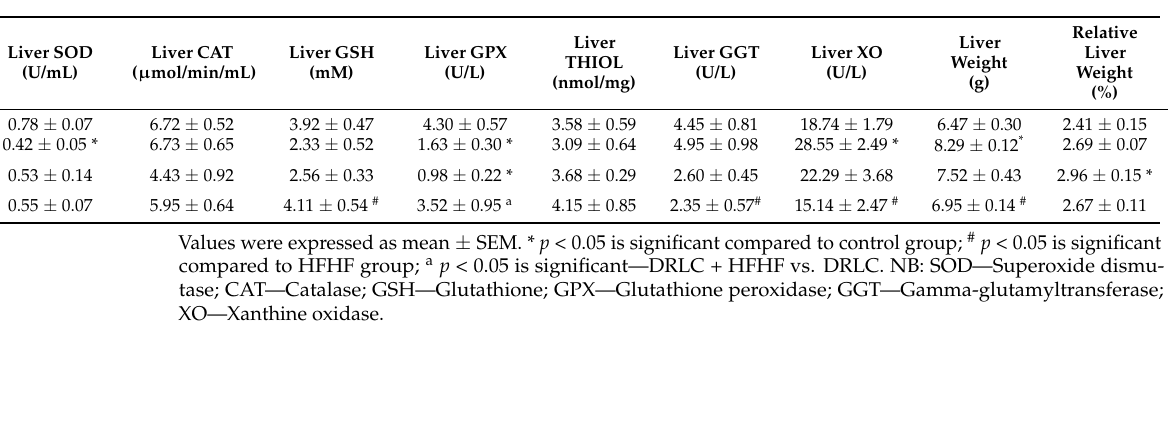
Table 3. Effects of D-ribose-L-cysteine (DRLC) on hepatic tissue oxidative indices, absolute and relative liver weight in male Wistar rats fed with high fructose-high fat (HFHF) diet.